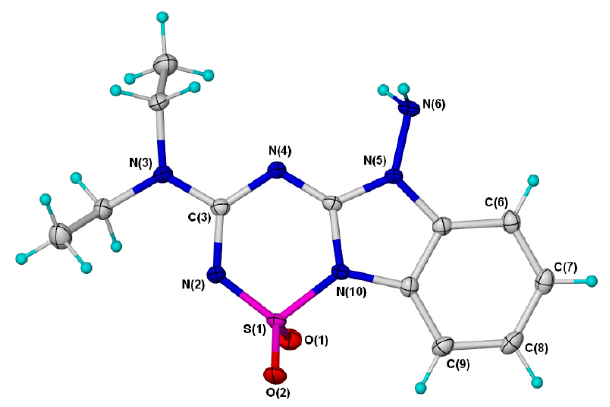
Figure 1. Crystal structure of 6 . The molecular diagram is shown with 50% thermal ellipsoids. Only one of the two unique molecules is shown. The other molecule is essentially the same as that shown, apart from the relative orientations of the ethyl groups of the NEt 2 substituent at C3. The crystal structure of 6 shows linear chain packing, formed by hydrogen bonding between the exocyclic amino groups and sulfonyl oxygen atoms of adjacent molecules (Figure 2).